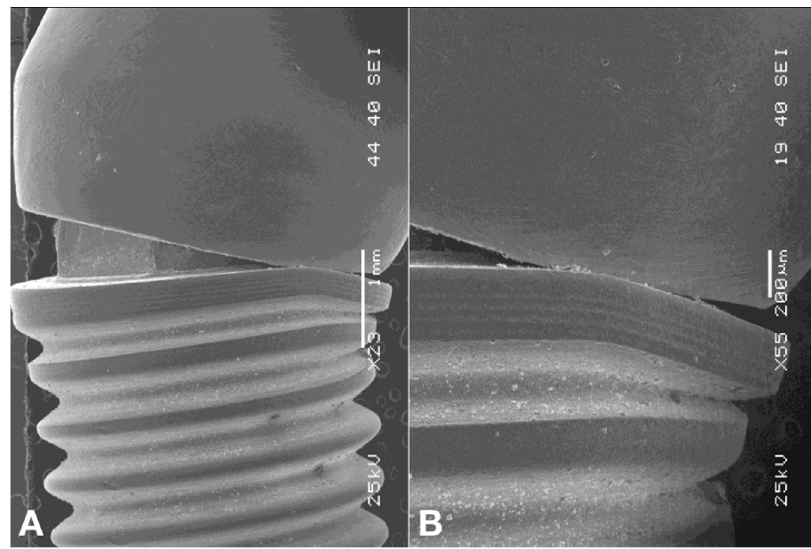
Figure 5. ( A ) On the angulation side of the abutment, the edge of the implant experienced plastic deformations characterized by crushing and consequent increase in marginal misfit. ( B ) Nevertheless, depending on the area measured, the gap diminished by compression of the abutment edge against the implant edge.